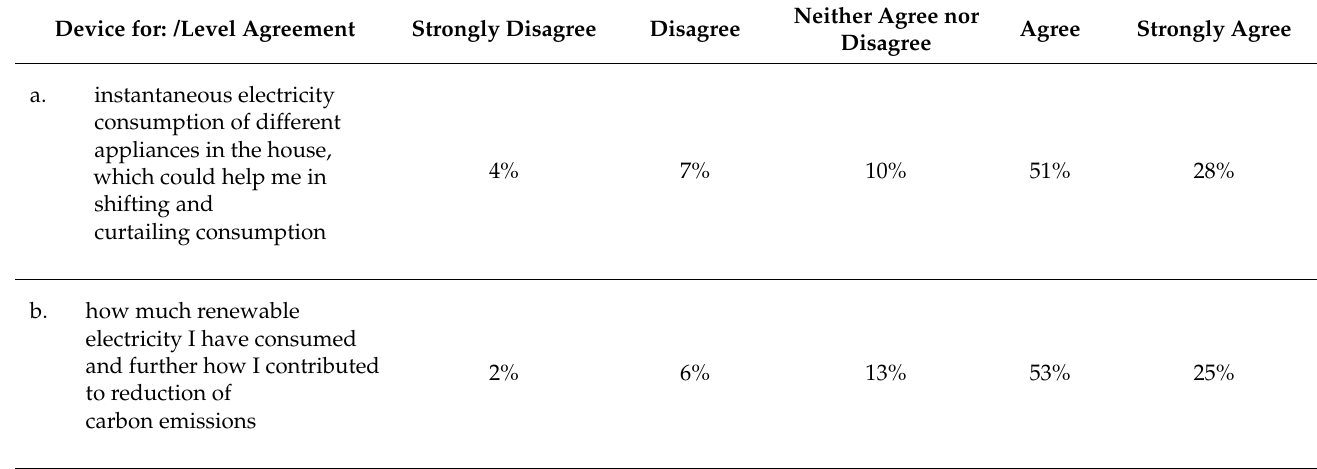
Figure 7. Participation of consumers in DR programs in order to reduce CO 2 and global warming (Consumers WITHOUT experience in Energy Sector). Source: Authors’ own research. Table 6. Consumers interest in using devices for electricity consumption